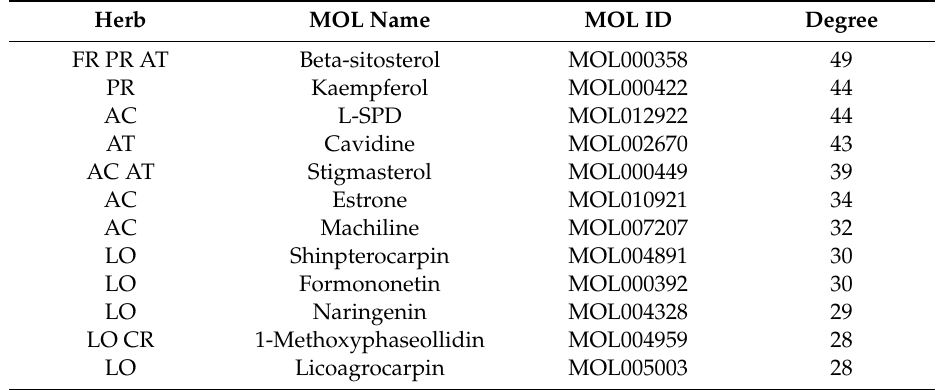
Table 2. The topological properties of key components.